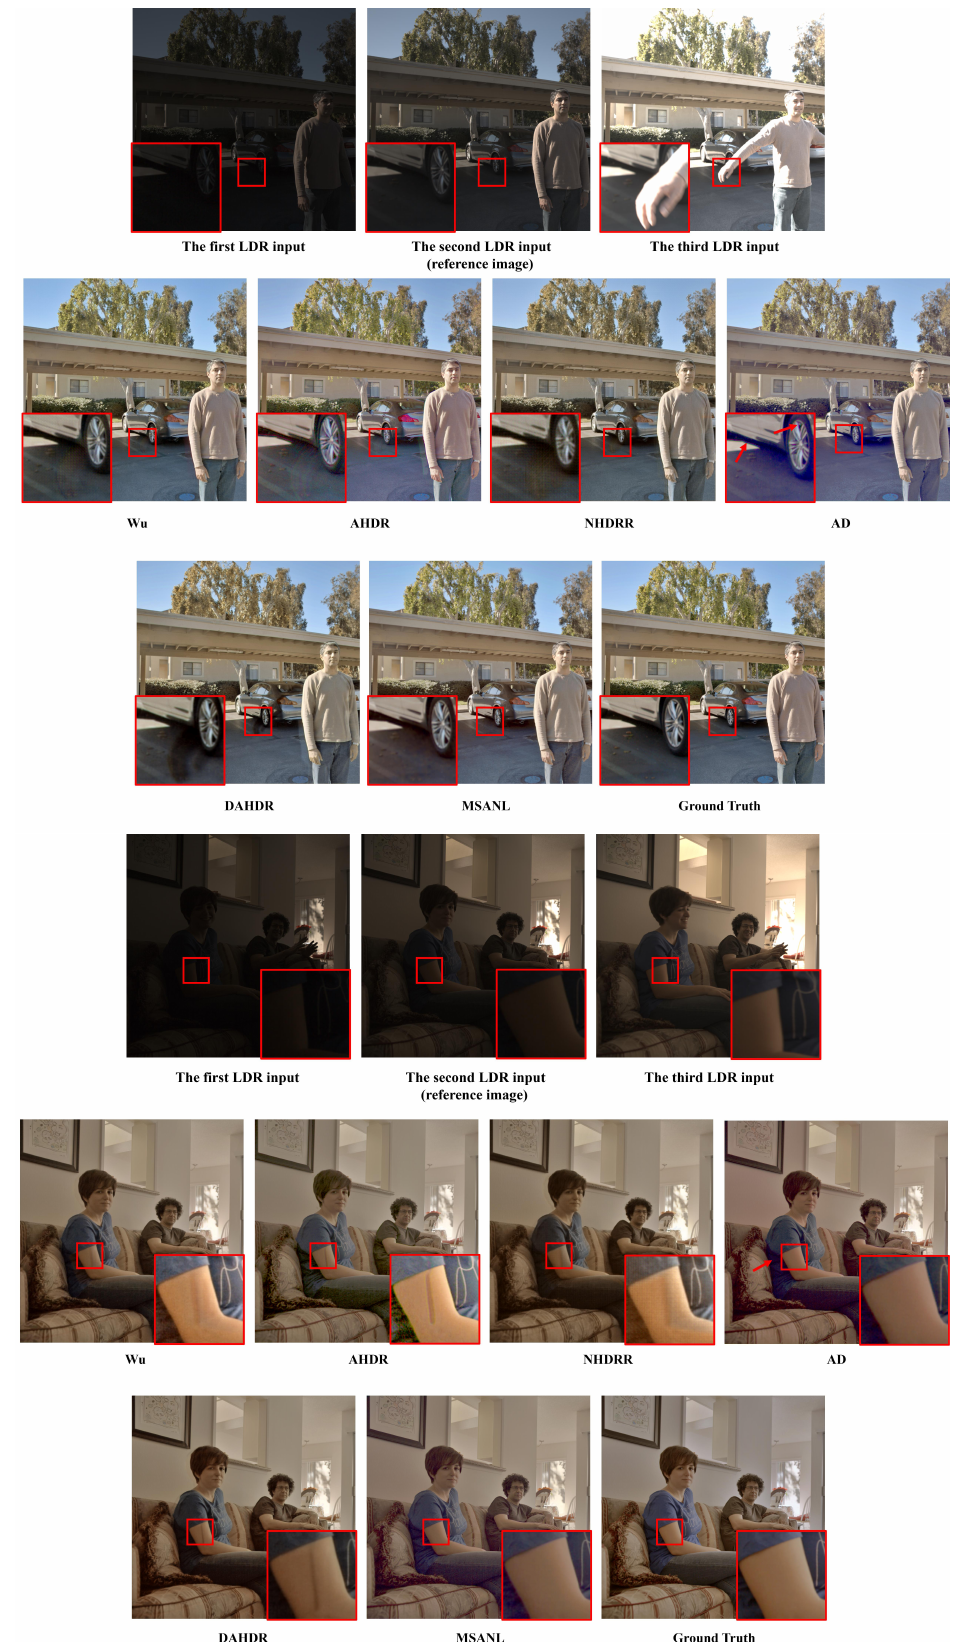
Figure 8. Visual comparison of HDR images restored from the dataset provided in [28]. From left, Wu [28], AHDR [26], NHDRR [30], AD [27], DAHDR [39], Proposed MSANLnet, and Ground